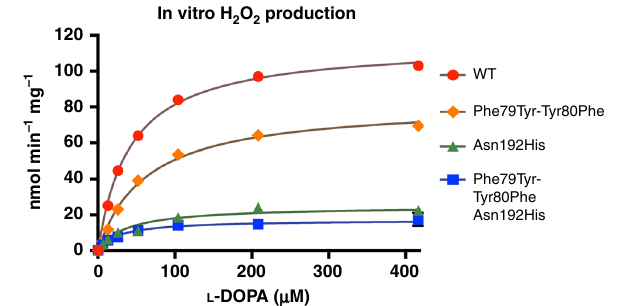
Fig. 5 Mechanism switching of B. mori DHPAAS. a Comparison of wild-type B. mori DHPAAS and Phe79Tyr-Tyr80Phe-Asn192His DHPAAS reaction schemes. General product amounts are indicated by the relative size of each molecule. b LC-MS MRM product ions are shown within each panel containing corresponding LC-MS chromatograms. MRM fragmentation of DHPAA standard matched that of the major product from wild-type (WT) DHPAAS reaction with L -DOPA. LC-MS MRM fragmentation of THP standard matched that of a major product from Phe79Tyr-Tyr80Phe-Asn192His DHPAAS reaction with L -DOPA